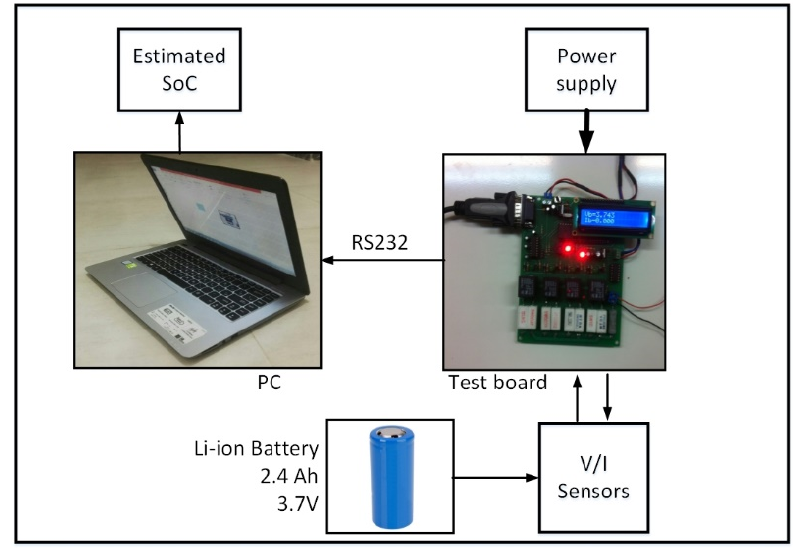
Figure 4. Test setup.